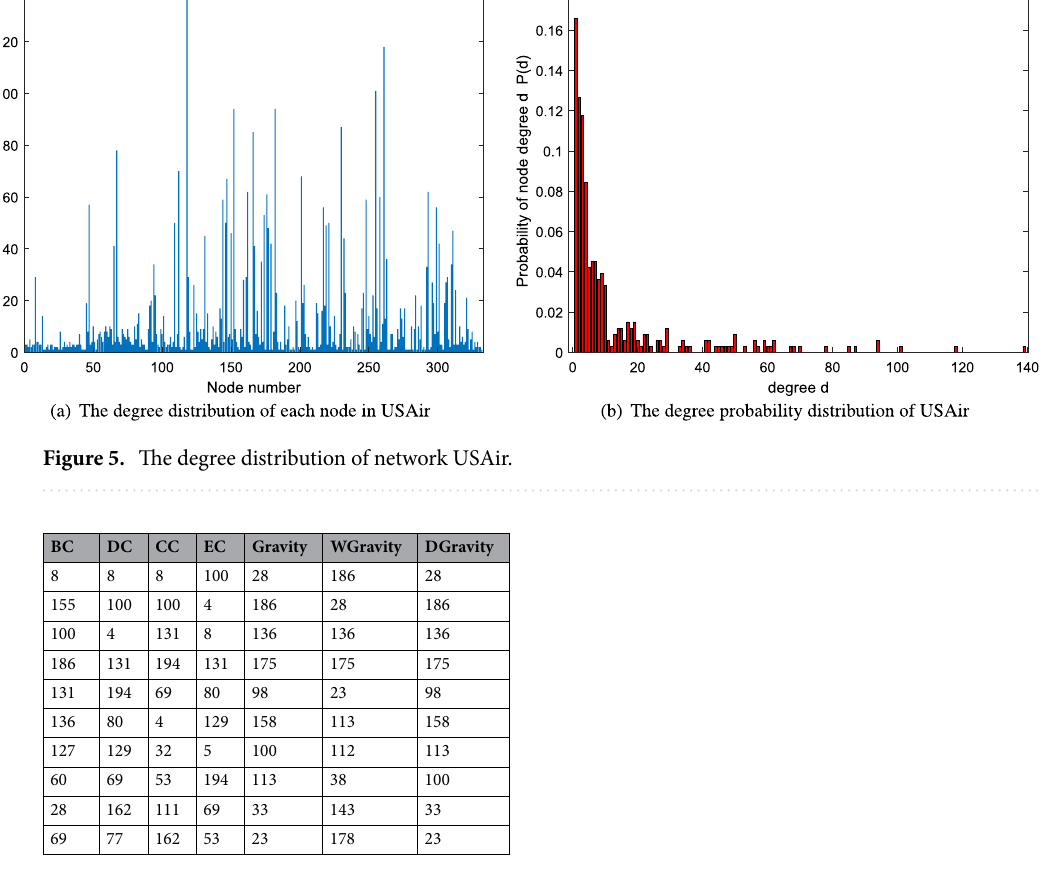
Table 2. The top 10 important nodes in